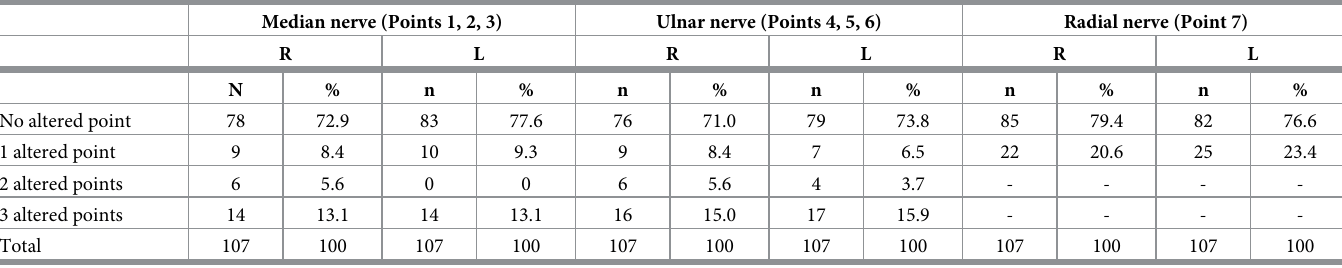
Table 7. Distribution of the number of SWM-test (normal and altered) points of the hands per patient at treatment diagnosis and corresponding nerves. Median nerve (Points 1, 2,